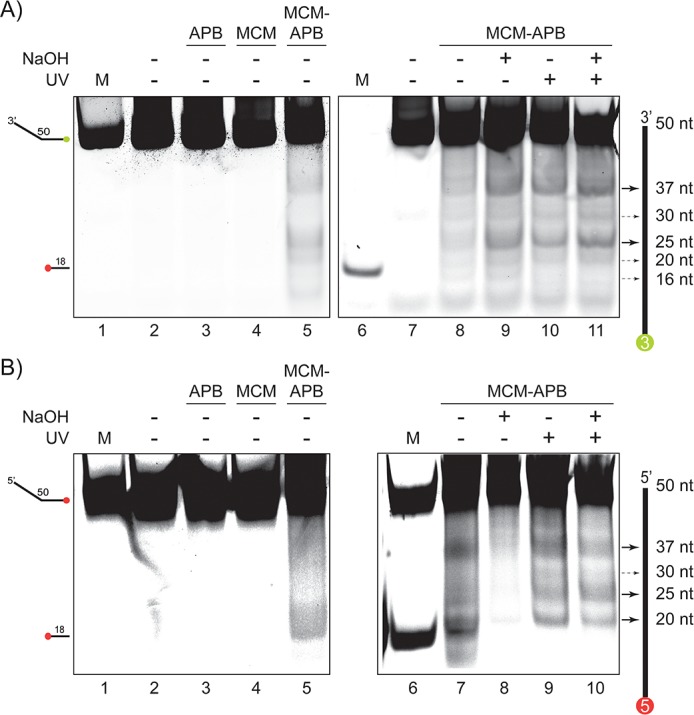
Validation of MCM-APB cleavage on ssDNA.(A) APB cleavage of a 5’-Cy3 labelled 50 nt ssDNA. No cutting in the absence of APB or MCM (lanes 2–4). MCM-APB can cleave DNA in the absence or presence of UV or NaOH (lanes 5, 8–11). (B) APB cleavage of a 3’-Cy5 labelled 50 nt ssDNA. No cutting in the absence of APB or MCM (lanes 2–4). MCM-APB can cleave DNA in the absence or presence of UV or NaOH (lanes 5, 7–10). Markers (M) at 50 or 18 nts are indicated.